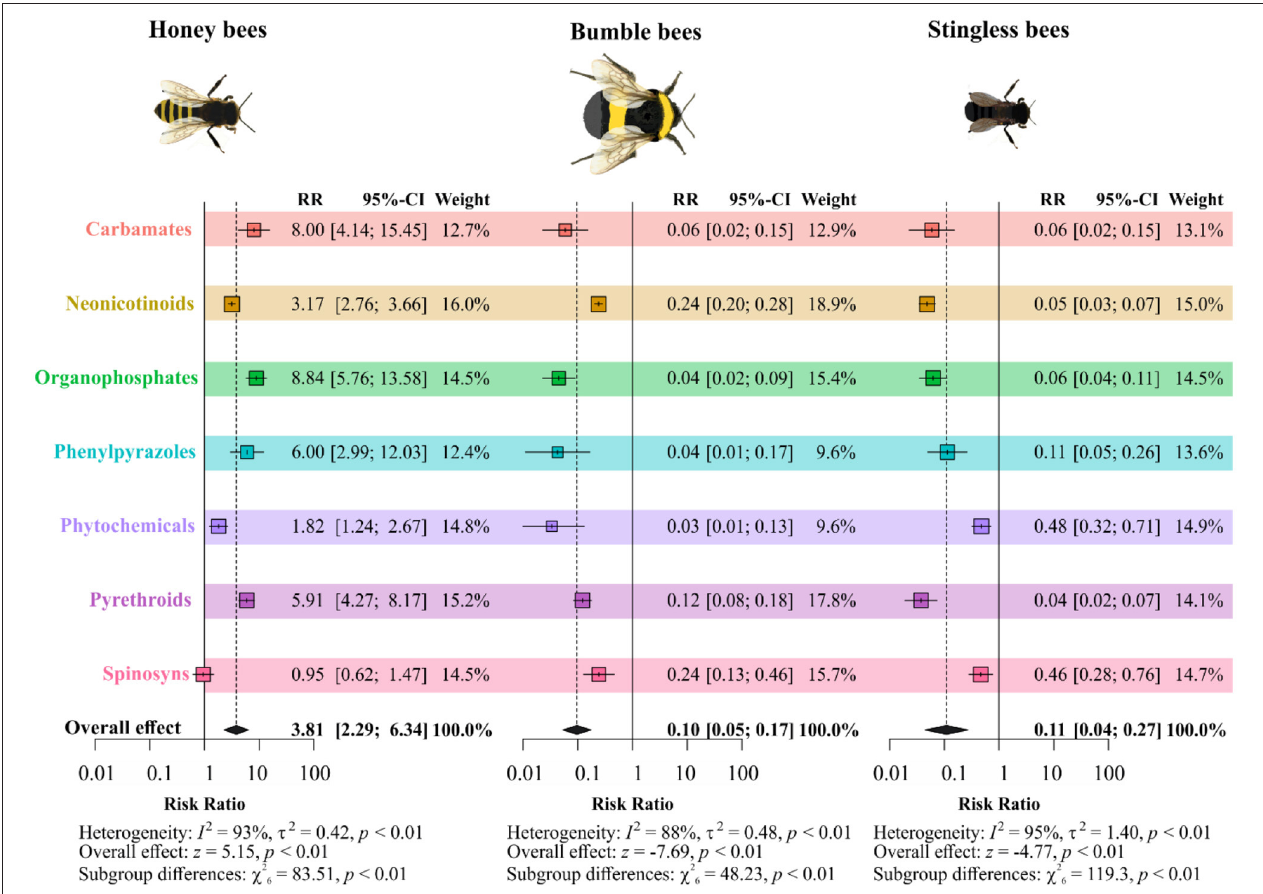
FIGURE 6 | Estimated size effect in the meta-analysis of the occurrence of published articles on toxicological assessment of the impact of insecticides on bees from the main groups found in the literature review. The forest plots depict the estimated risk ratio (RR), 95% confidence interval (CI), and weight (inverse of the variance; larger squares indicate more precise results, i.e., small variances). The black diamond shape indicates the summary of RR ± 95% CI (overall effect for all insecticides). These estimates are based on mixed-effect model meta-analyses with inverse-variance and DerSimonian–Laird methods. RR ± 95% CI > 1 indicates a high likelihood of published articles covering the effects of agrochemicals in the bee group, while RR ± 95% CI < 1 indicates a low likelihood, and no bias is present when RR ± 95% CI includes